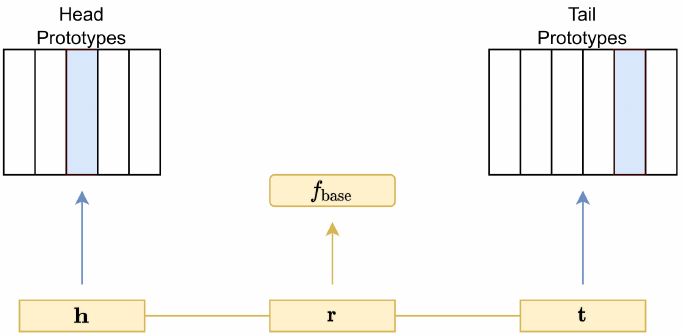
Figure 2. Structure of proposed method ProtoE. Each relation is associated with head prototypes and tail